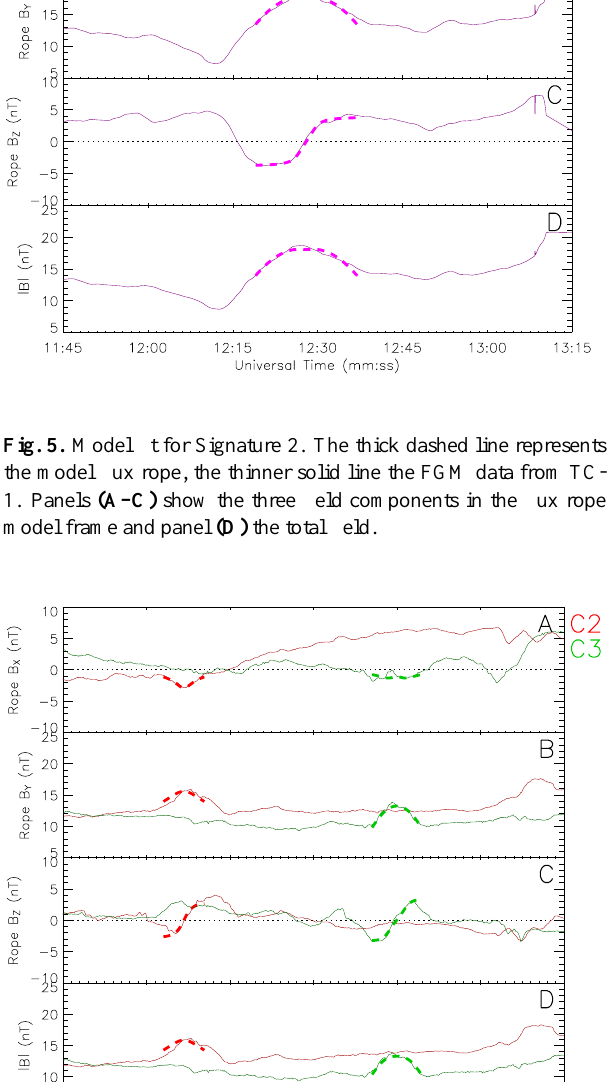
least well. In Fig. 6, the traces for C2 and C3 are offset by ∓ 10 s,